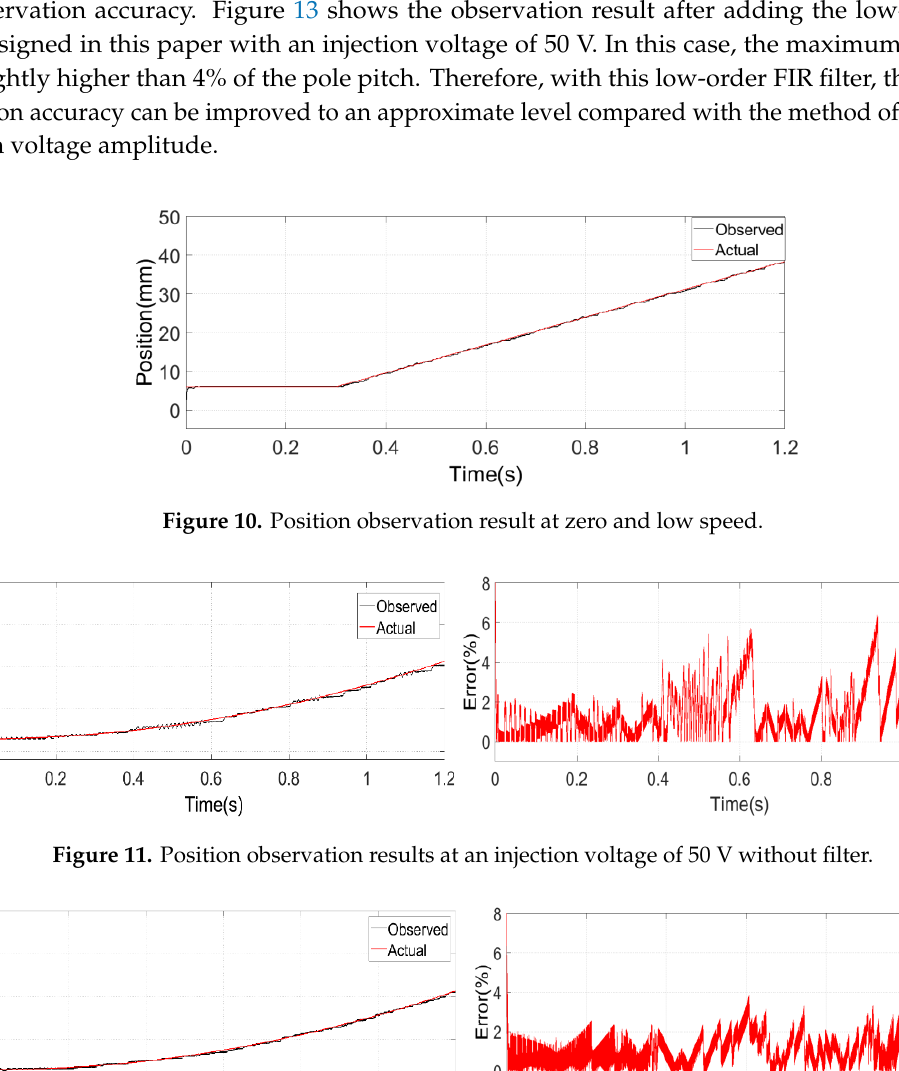
i before and after signal processing.